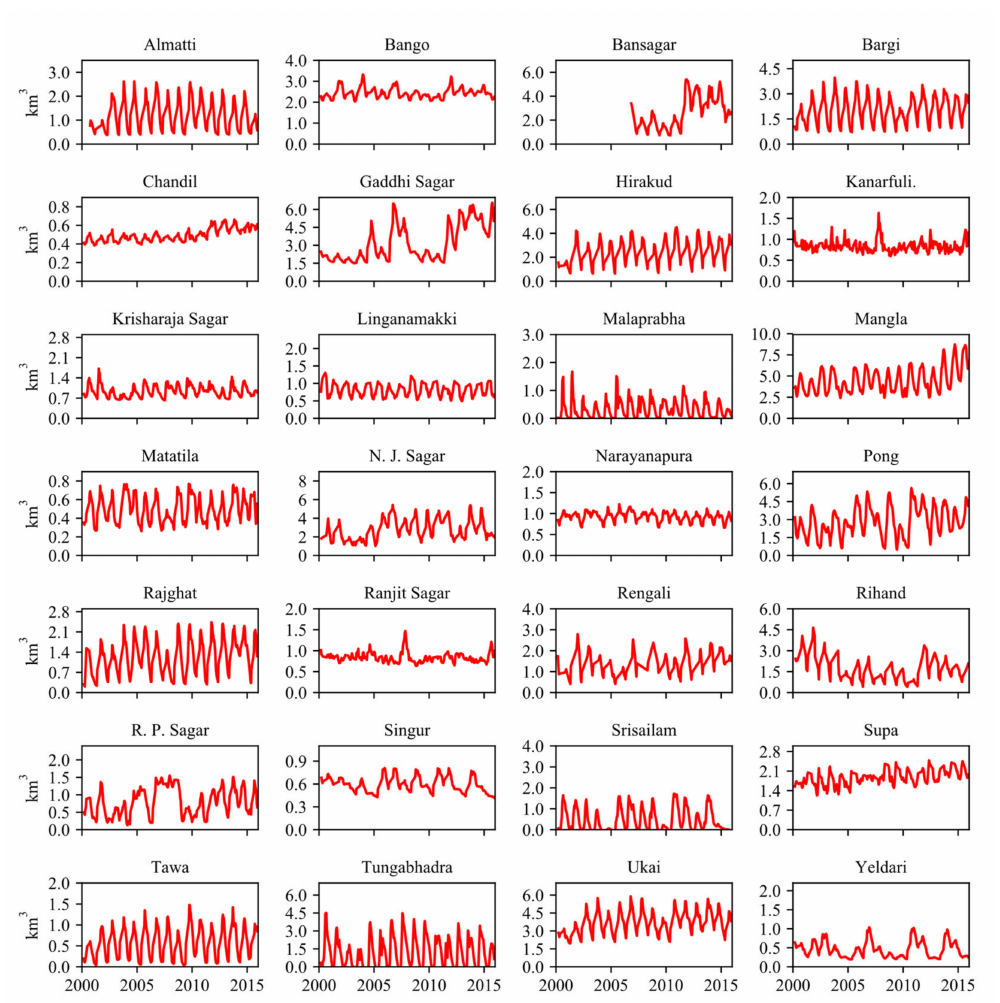
Figure 6. Combined remotely sensed storage time series of the South Asian reservoirs analyzed in this